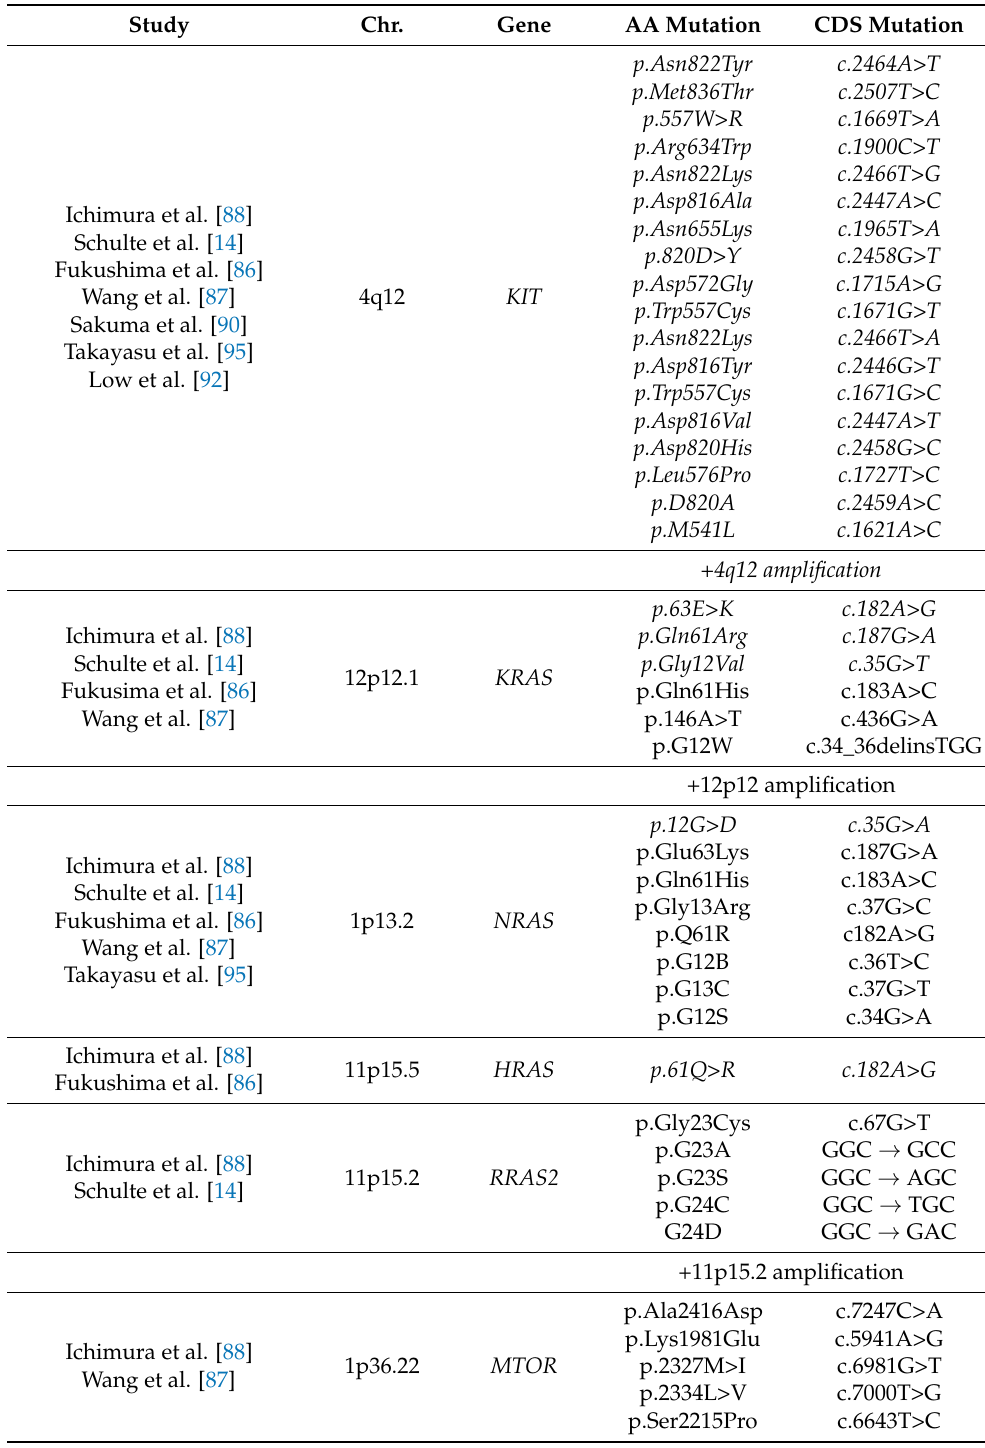
Table 5. Genes with possible pathogenic role in germinomas, reported in at least two distinct studies. Study Chr. Gene AA Mutation CDS